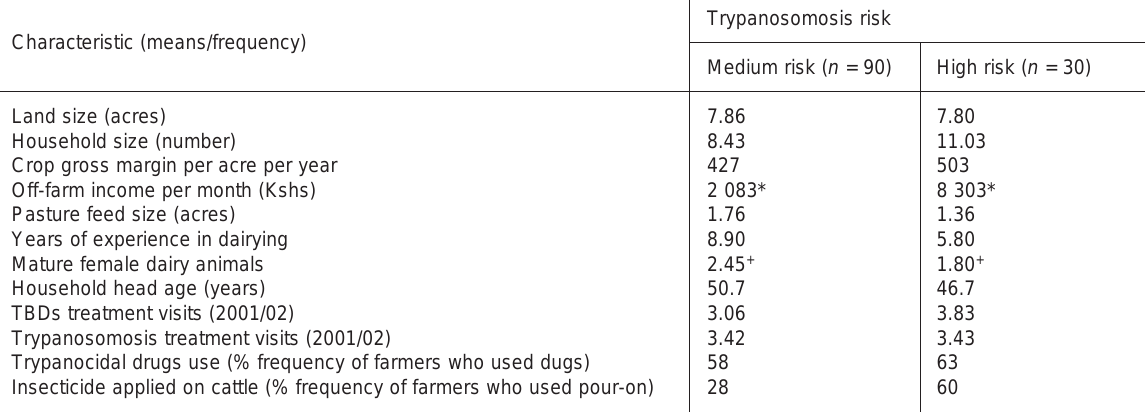
Trypanosomosis risk